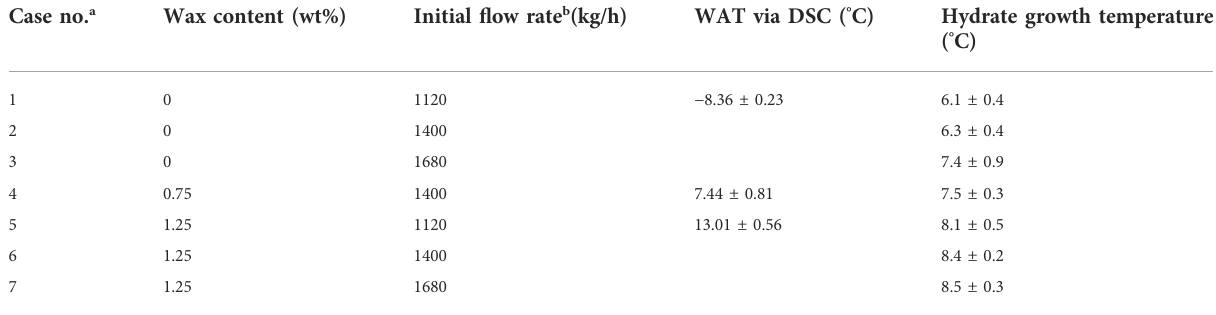
TABLE 3 Experimental conditions for hydrate formation and slurry fl ow in a fl ow-loop system. Case no. a